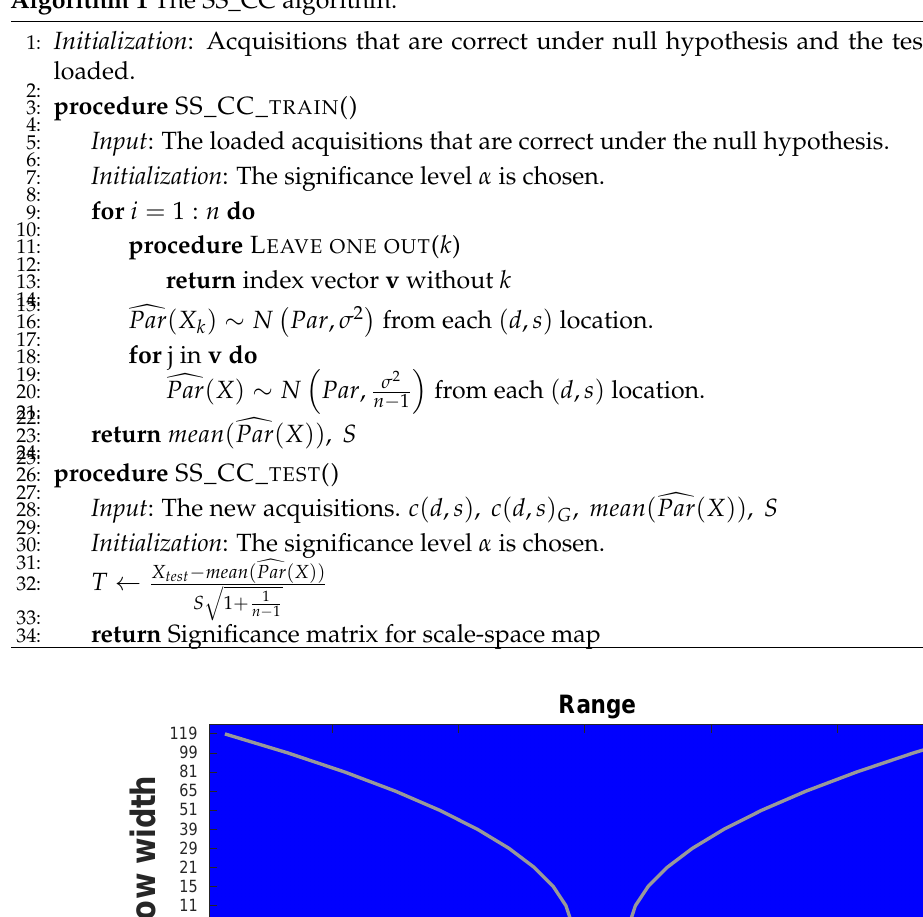
Algorithm 1 The SS_CC algorithm: